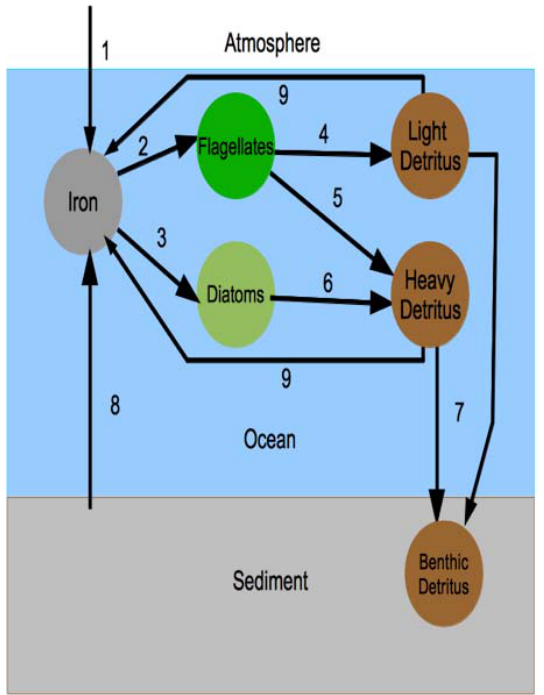
Fig. 4. Iron cycle in ECOHAM: (1) atmospheric iron deposition, (2) consumption of iron by flagellates, (3) consumption of iron by diatoms, (4, 5, 6) mortality and egestion, (7) sinking of detritus in the water column, (8) benthic remineralisation, and (9) pelagic